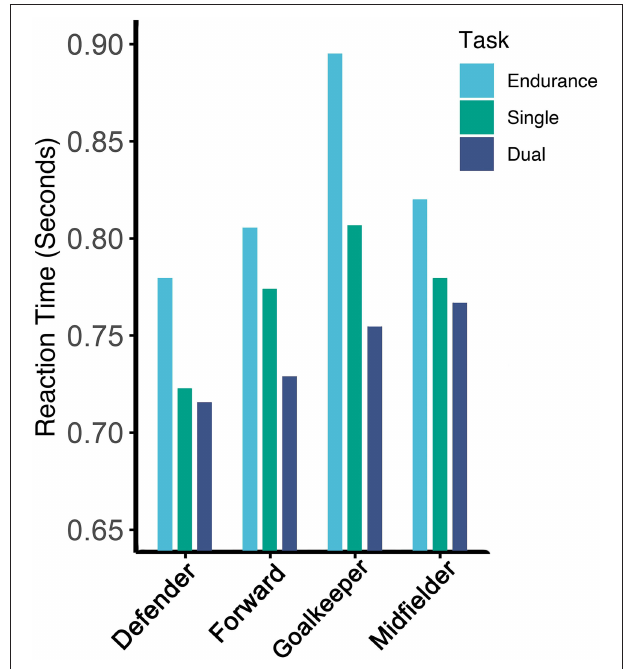
FIGURE 3 | Total proactive reaction time by position. It demonstrates positional means in total reaction time, in seconds, by position during each of the three proactive